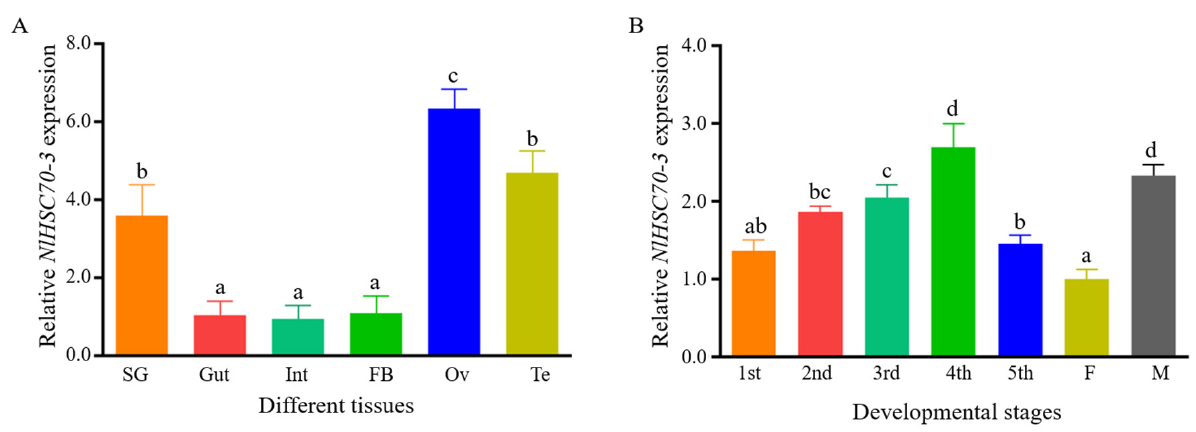
Figure 2. Expression pattern of NlHSC70-3 in the BPH. ( A ) Relative expression levels of NlHSC70-3 in different tissues were normalized against the amount of expression in the gut. The relative expression was calculated from three biological replicates. SG = salivary glands, Gut = guts, Int = intestines, FB = fat bodies, Ov = ovary, Te = testis. ( B ) Expression patterns of NlHSC70-3 gene at developmental stages. The 1st to 5th instar; F, female adult; M, male adult, determined by qRT-PCR. Relative expression levels of NlHSC70-3 in developmental stages were normalized against the amount of expression in the female. Data were analyzed by one-way ANOVA and repeated three times according to three biologically independent samples. Different lowercase letters above bars indicate significant differences.